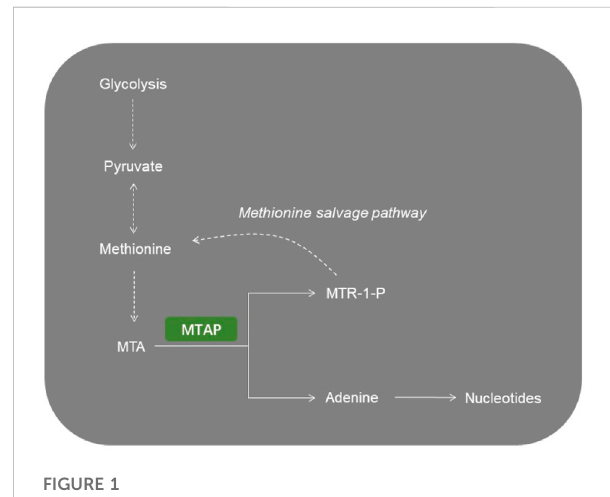
FIGURE 1 Representative image of MTAP-related metabolic